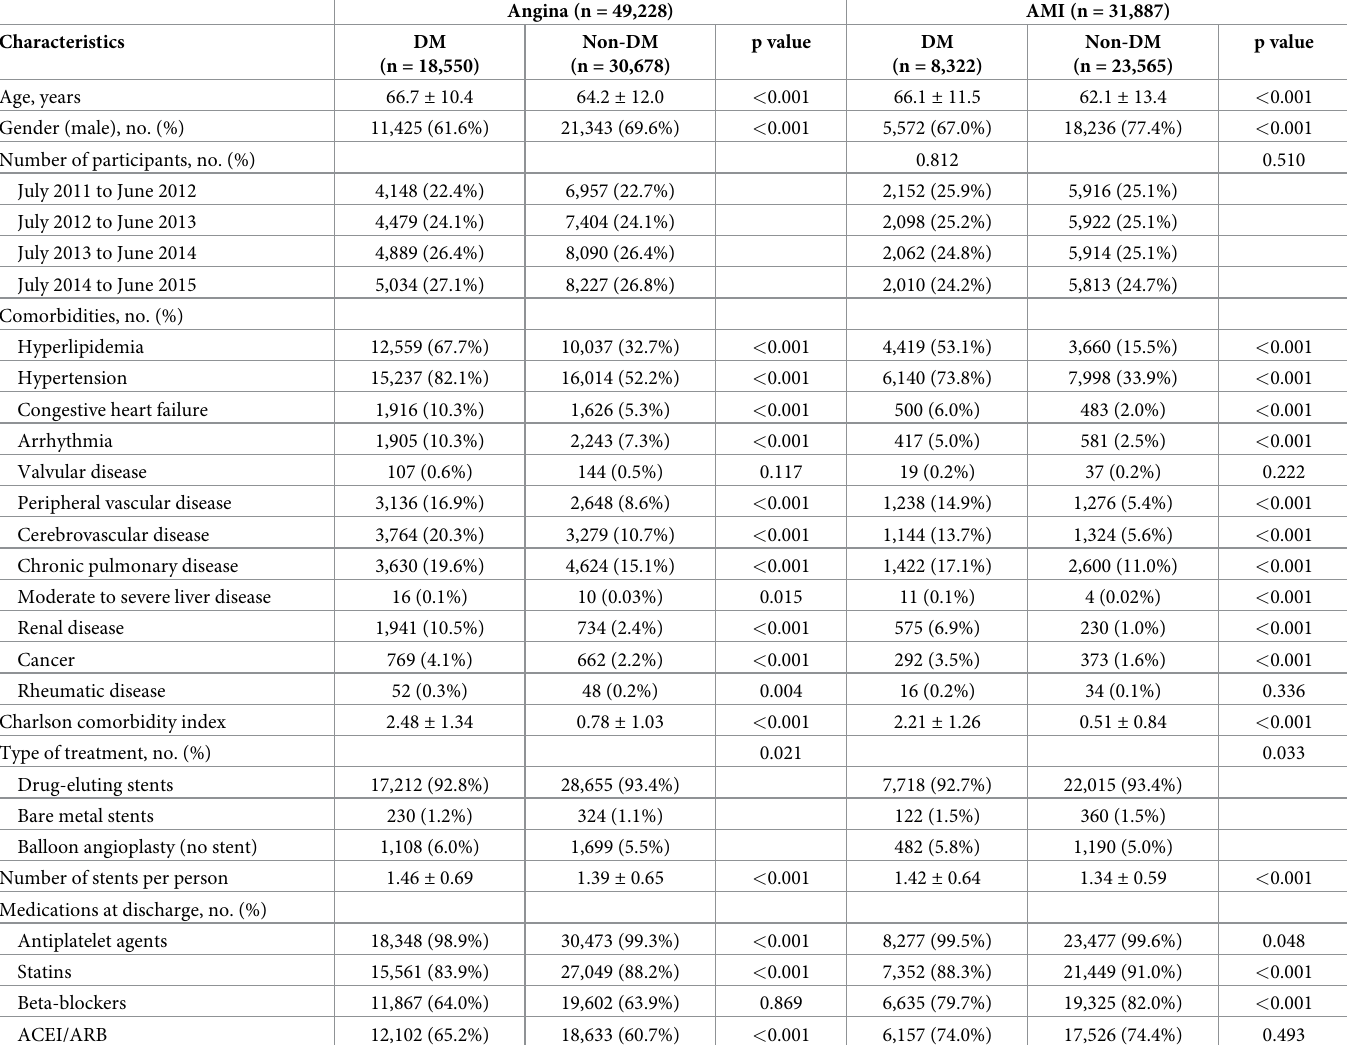
Table 1. Characteristics of patients undergoing percutaneous coronary intervention according to the presence of diabetes